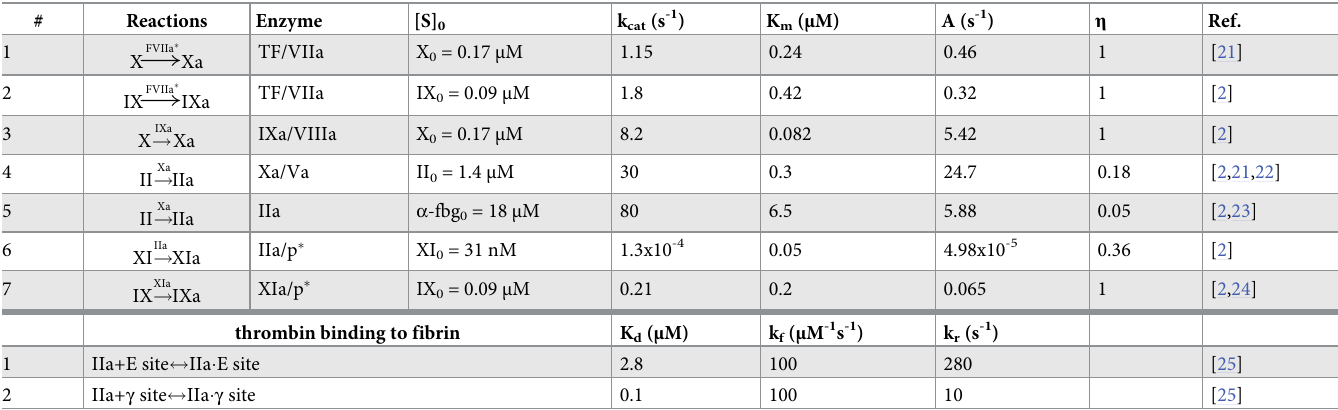
Table 1. Reactions and kinetic parameters used in the ODEs